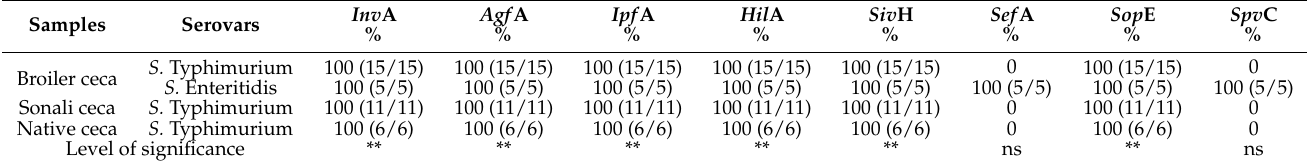
Table 4. Prevalence of virulence genes of Salmonella enterica